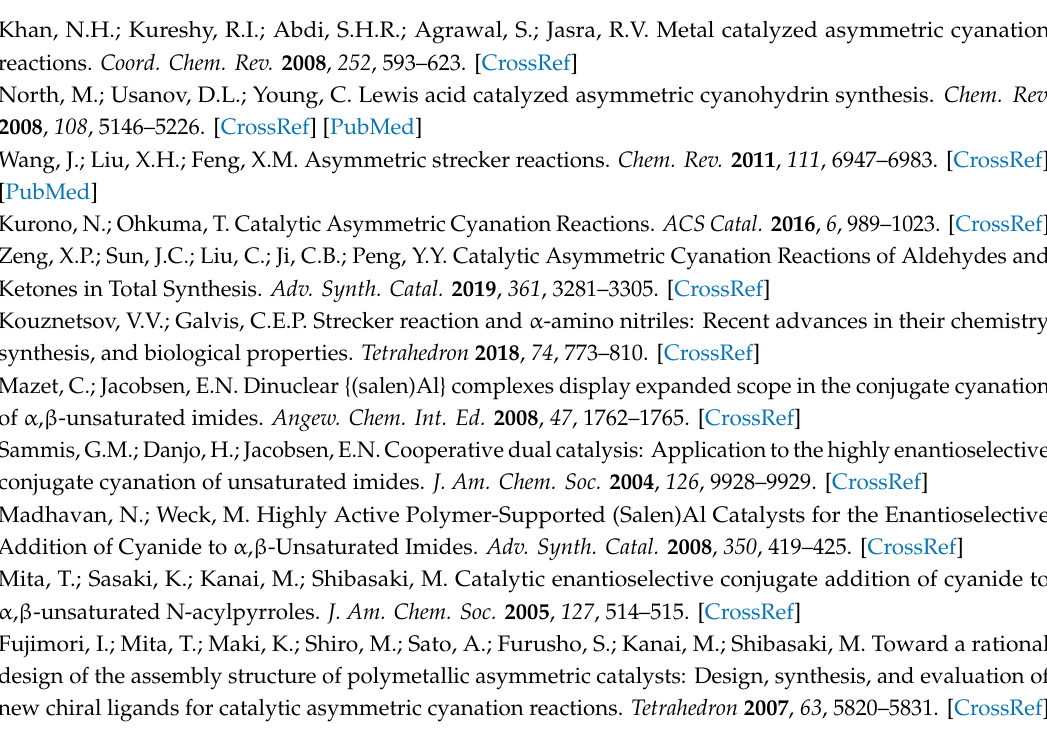
Figure S1: Laplacian ( ∇ 2 ρ ) and electronic density ( ρ , in parentheses) of selected bond critical points (BCP) for molecular complex C-I-COM were obtained by AIM analysis, using Multiwfn software. Figure S2: Optimized geometry of transition state b-TS1-1. The intermolecular distance is in Angstroms (Å). The color definitions of atoms are Red = oxygen, blue = nitrogen, gray = carbon, and white = hydrogen. Figure S3: Optimized geometries of low-energy hexacoordinated Ti(IV)-complexes formed by coordinating olefin to metal center in (a) bidentate (b) monodentate fashion along si -face attack pathway. The intermolecular distance is in Angstroms (Å). The color definitions of atoms are Red = oxygen, blue = nitrogen, gray = carbon, and white = hydrogen. Figure S4: Optimized geometries of hexacoordinated Ti(IV)-complexes and H-shift transition state in the presence of HOiPr along si -face attack pathway. The intermolecular distance is in Angstroms (Å). The color definitions of atoms are Red = oxygen, blue = nitrogen, gray = carbon, and white = hydrogen. Figure S5: Optimized geometries of two competing transition states in C-C bond formation step in d-II and d-III models as well as their relative Gibbs free energies (in kcal mol − 1 ). The intermolecular distance is in Angstroms (Å). The color definitions of atoms are Red = oxygen, blue = nitrogen, gray = carbon, and white = hydrogen. Figure S6: Visualization of the main noncovalent interaction described by contour plots of the reduced density gradient isosurfaces (density cuto ff of 0.7 au) for transition states d-I-TS1- si and d-I-TS1- re . The surface color code is blue for strongly attractive, green for weakly attractive, and red for strongly repulsive